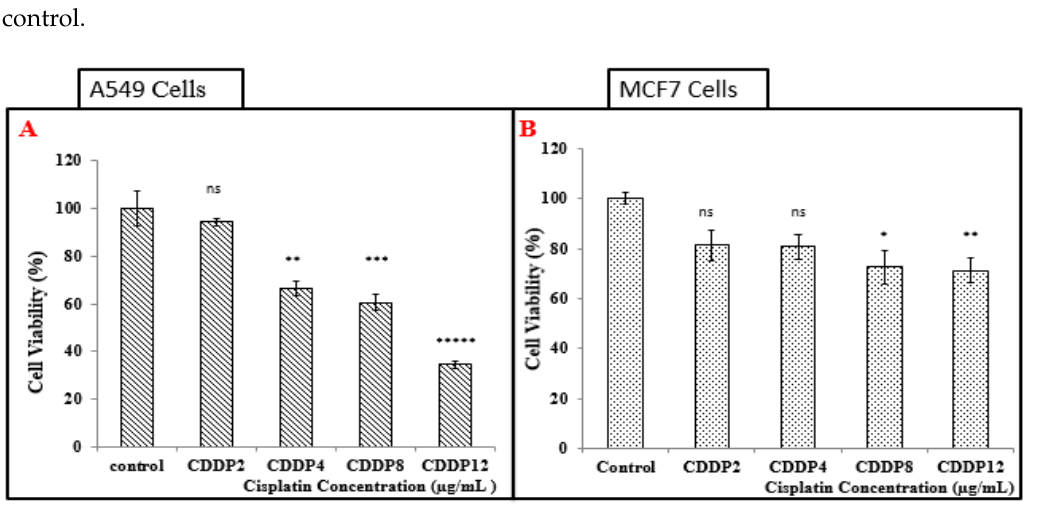
Figure 3. Cell viability of A549 and MCF-7 cell lines after treatment for 24 h with cis-dichloro-diamine-platinum (CDDP). ( A ) Cell viability of A549 cells after treatment with increasing concentrations of CDDP for 24 h. ( B ) Cell viability of MCF-7 cells after treatment with increasing concentrations of CDDP for 24 h (* p < 0.05, ** p < 0.01, *** p < 0.001, **** p < 0.001).